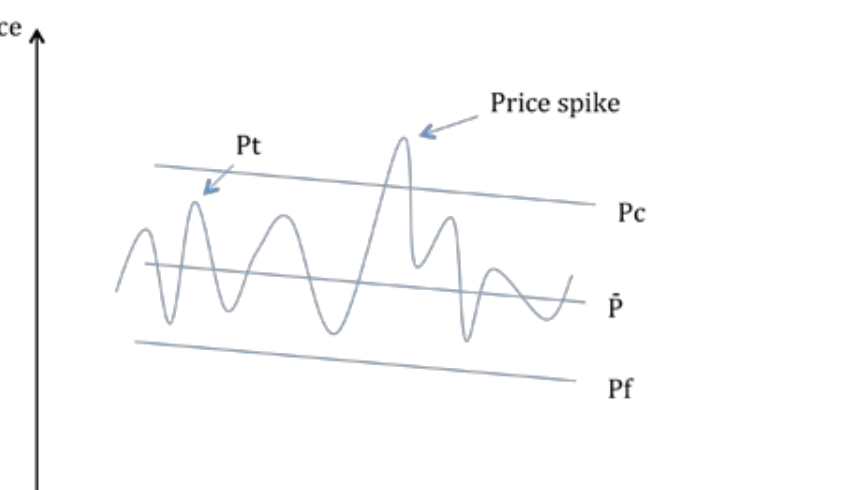
Figure 2. Defining price